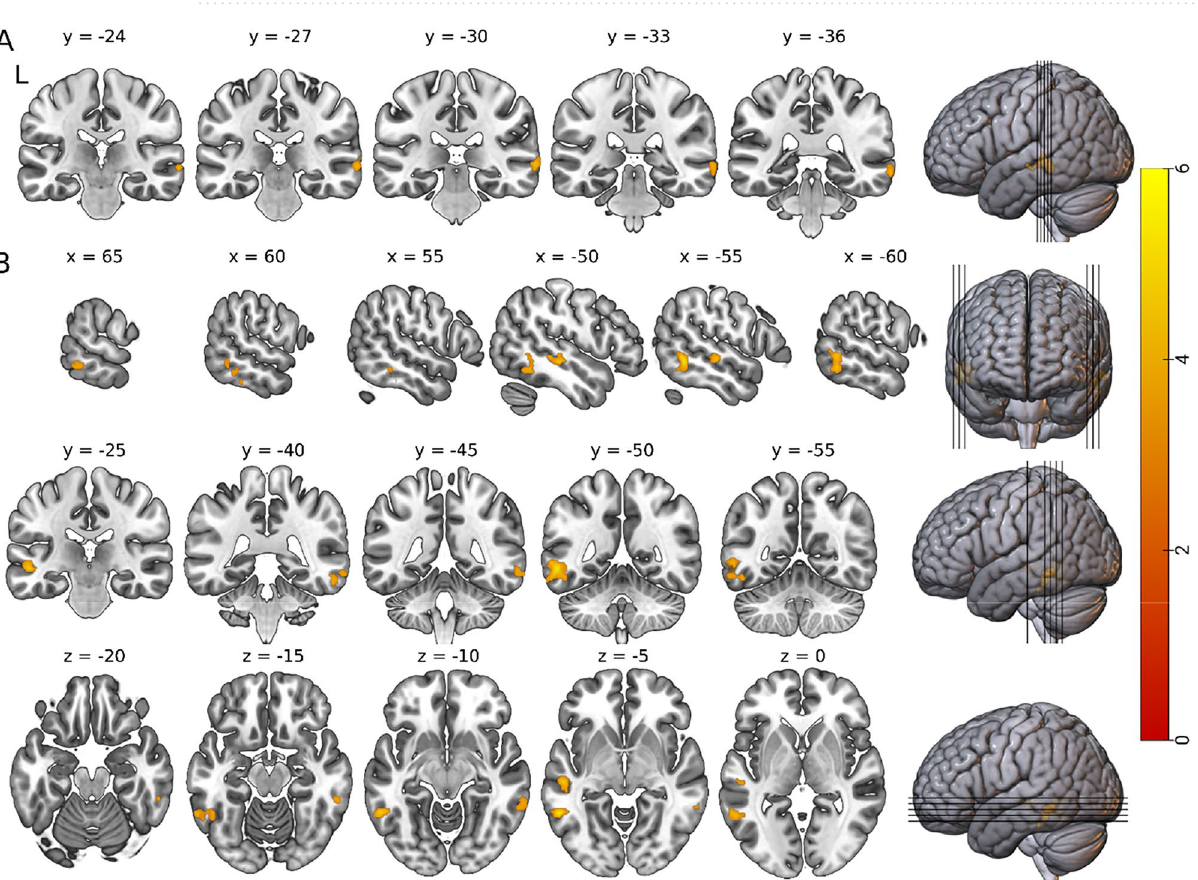
Figure 5. t statistical map from seed-to-voxel exercise > rest, post > pre. Slice views of significant peaks (cluster threshold p < 0.05 FWE-corrected, p < 0.001 uncorrected at voxel level) using ( A ) the right lobule 9 of the cerebellum and ( B ) the right lobule 10 of the cerebellum as the seed regions. Slice views of significant peaks (cluster threshold p < 0.05. cluster size p < 0.05 FWE-corrected) between ( A ) the right lobule 9 of the cerebellum (seed) and the right middle temporal gyrus (T(39) = 5.58, k = 132, p‑ FWE = 0.011), and between ( B ) the lobule 10 of the cerebellum (seed) and three significant clusters. The first cluster was located in the left middle temporal gyrus and the left inferior temporal gyrus (T(39) = 5.69, k = 254, p‑ FWE < 0.001), the second cluster was located in the right middle temporal gyrus (T(39) = 5.49, k = 113, p‑ FWE = 0.019), and a third cluster located in the left middle temporal gyrus and left superior temporal gyrus (T(39) = 5.16, k = 107, p‑ FWE =